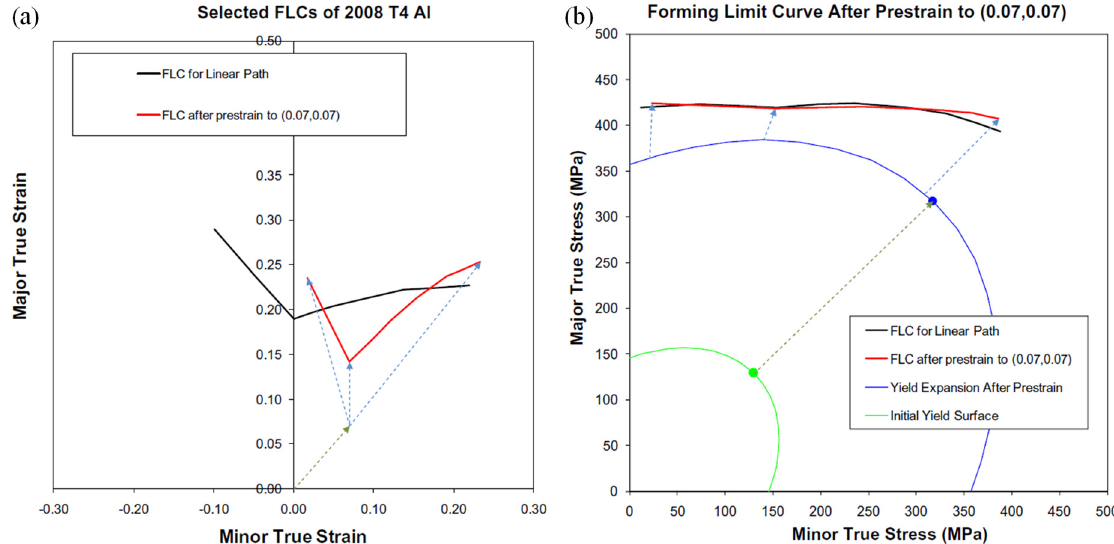
Figure 26. The transformation from an FLD to an FLSD. ( a ) FLD which contains two FLCs including one FLC with pre-strain; ( b ) transformed FLCs in the FLSD. Reprinted from Ref. [335] with permission. Copyright 2012, Elsevier.